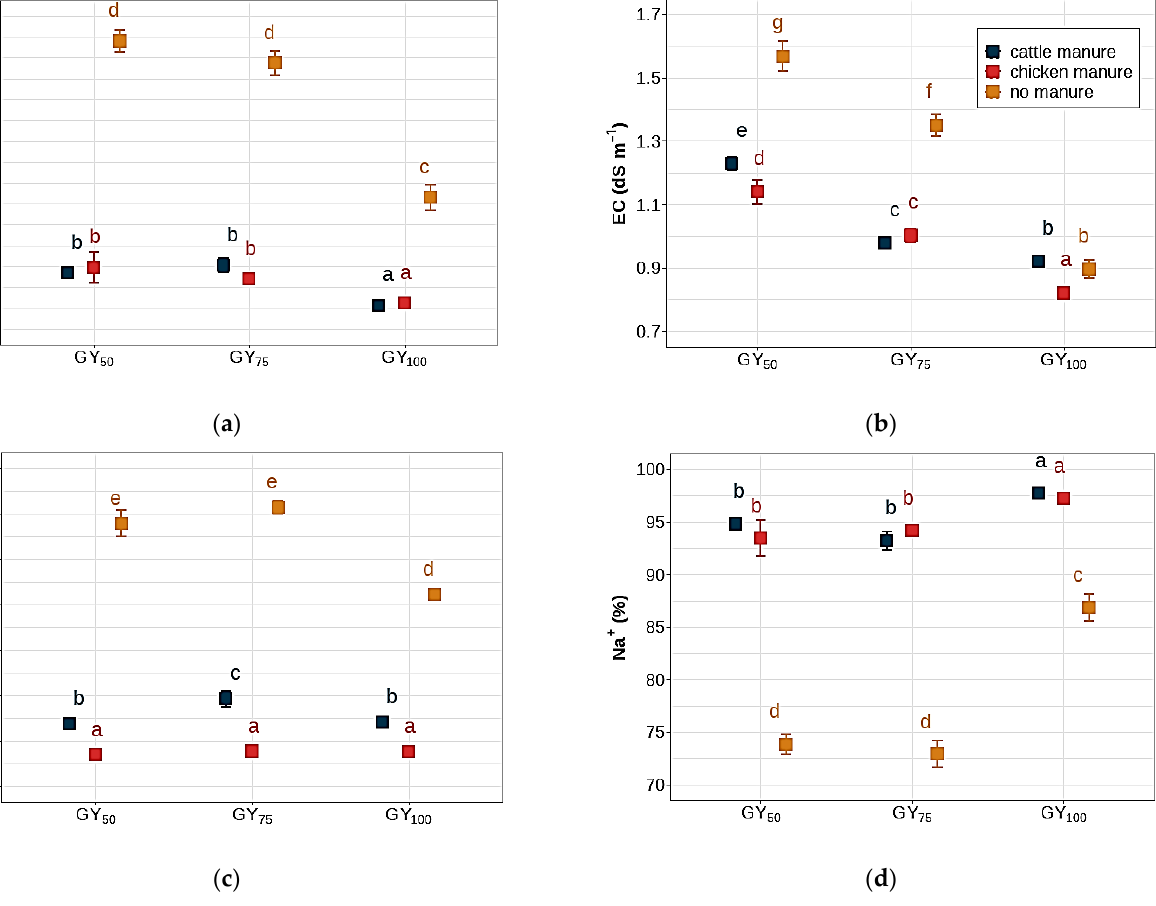
Figure 1. Soil ESP ( a ), EC e ( b ), pH ( c ) and displaced Na + ( d ) for the interactions between manures/no manure and gypsum levels. Means sharing a letter are not significantly different, according to the Scott – Knott test ( p = 0.05). The bars indicate the standard error.